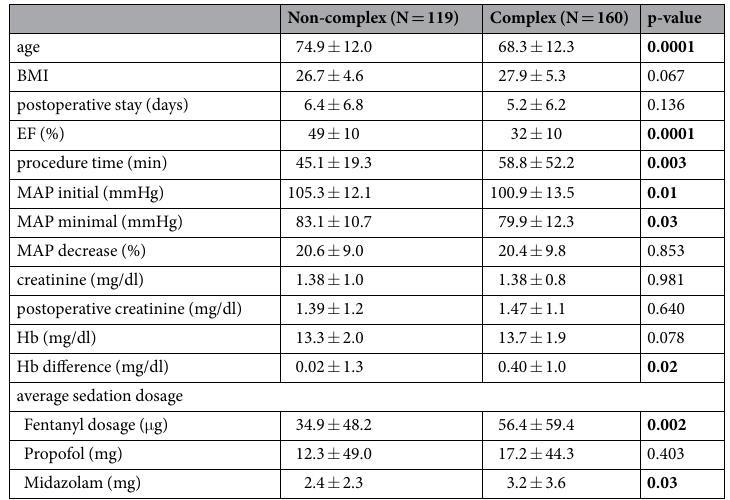
Table 2. Sedation use and dosage by procedure type. ASA, American Society of Anesthesiologists; BMI, body mass index; EF, ejection fraction; Hb, haemoglobin; MAP, mean arterial